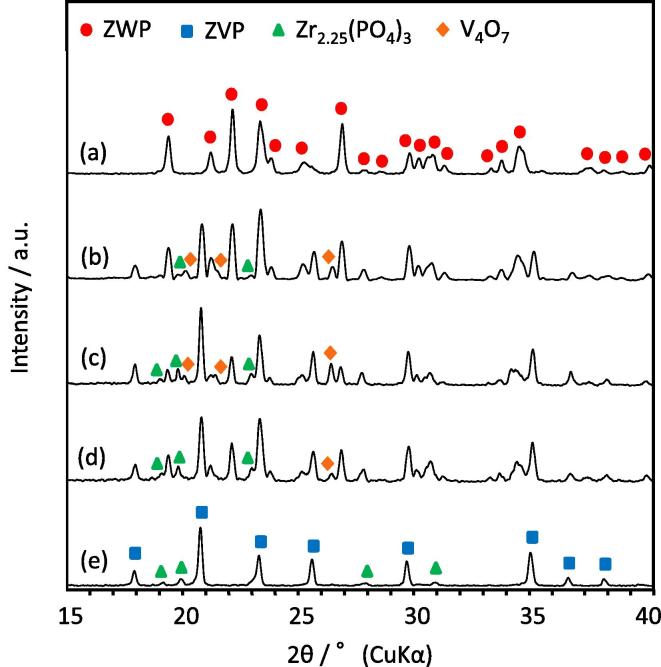
XRD patterns of ZrV0.6P1.4O7 (ZVP)/Zr2WP2O12 (ZWP) composites fabricated at VZVP/VZWP ratios of (b) 0.6/0.4, (c) 0.55/0.45, and (d) 0.53/0.47, in addition to sintered bodies of (a) ZVP and (e) ZWP fabricated. All samples were sintered at 1000 °C for 20 h in air. (●) Zr2WP2O12 (ZWP), (■) ZrV0.6P1.4O7 (ZVP), (▲) Zr2.25(PO4)3, and (◆) V4O7.